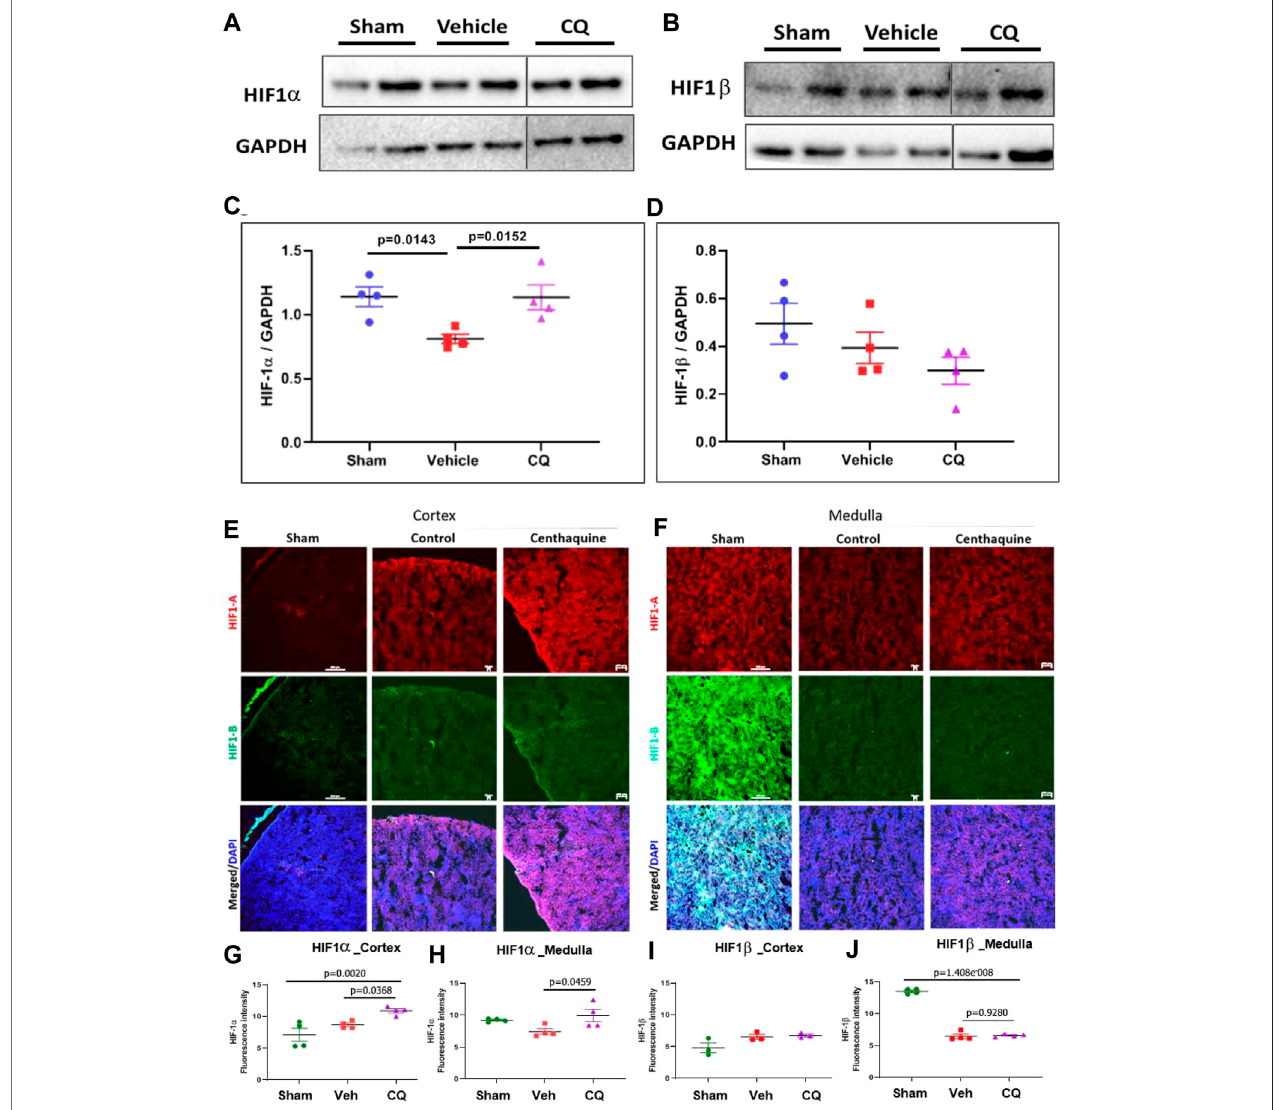
FIGURE 4 | Effect of CQ on expression of hypoxia responsive factors in kidneys. A and B, representative western blots of HIF-1 α (A) and HIF-1 β (B) and their respective GAPDH (loading control). (C, D) , graphical representation of HIF-1 α /GAPDH (C) and HIF-1 β /GAPDH ( D ) normalized data. The error bar represents mean ± SEM. N (cid:1) 4.Blackverticallinesin AandB showthatthe bandswerecroppedfrom thesame blot (fullblotsare provided as Supplementary FiguresS1, S2 ).Statistical analysis Ordinary One Way ANOVA and Fisher ’ s test. E and F, representative images of immuno fl uorescence of HIF-1 α (red) and HIF-1 β (green) in cortex (E) and medulla (F) insham,vehicle(control)andCQ. (G – J) ,graphsofmean fl uorescenceintensityofHIF-1 α incortex( G )andmedulla (H) ,andofHIF-1 β incortex (I) andmedulla (J) . N (cid:1) 4. Nuclei in all immuno fl uorescence microscopy images were stained with DAPI (blue). Statistical analysis- Ordinary One Way ANOVA and Fisher ’ s